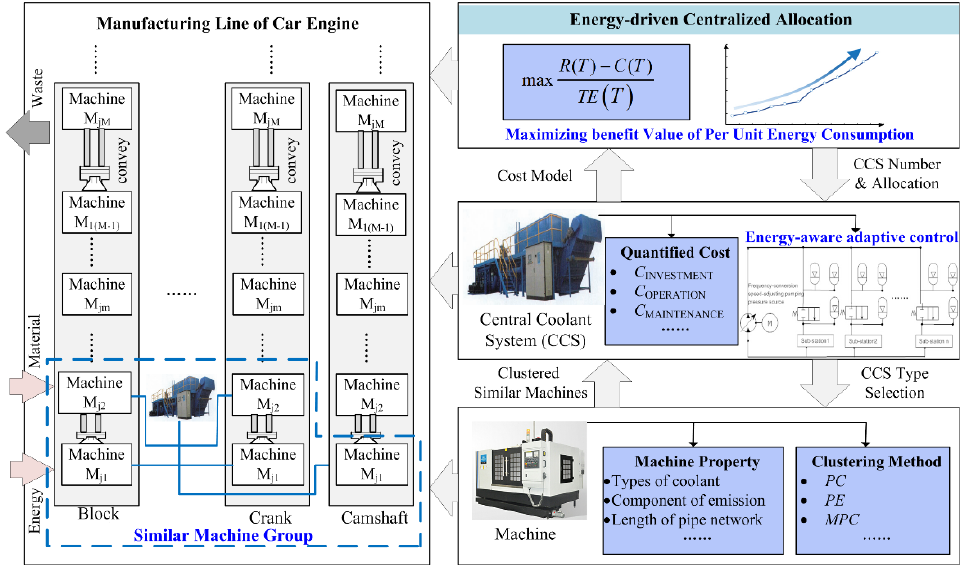
Figure 8. Framework of energy-driven supply/collect centralized